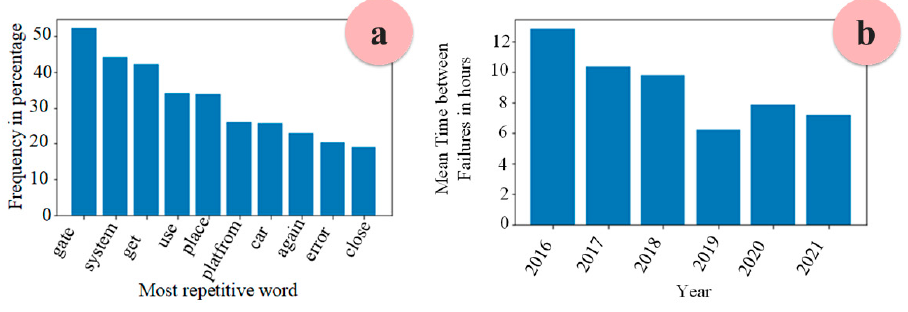
Figure 12. Internal data include ( a ) frequency of most repetitive words ( b ) MTBF per